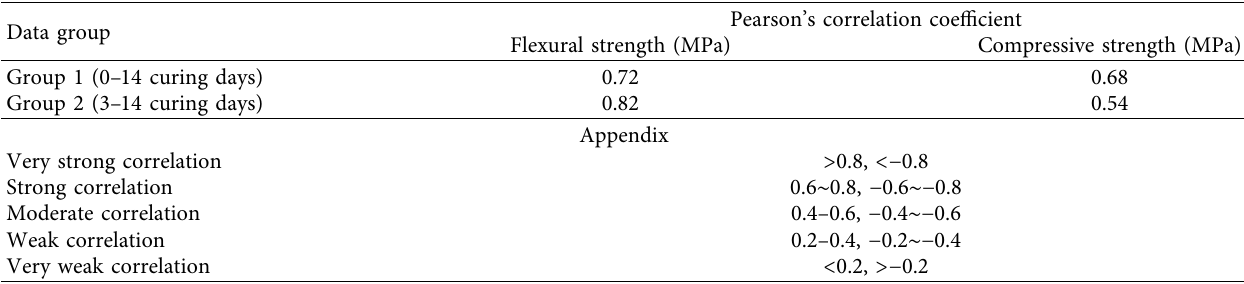
Figure 6: Flexural and compressive strength of grouting materials with different curing times. (a) Flexural strength. (b) Compressive strength. Table 5: Pearson’s correlation analysis results of grouting materials’ strength